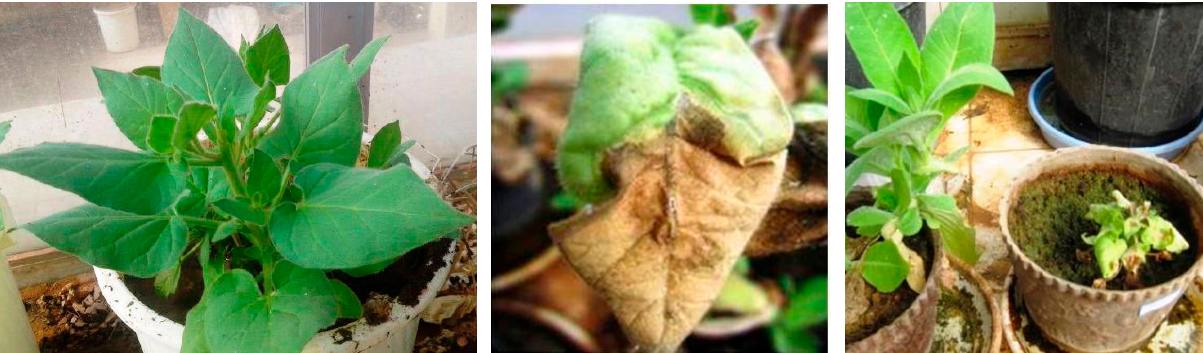
Figure 4. Healthy plant of tobacco (control, left), progressive development of tobacco leaf symptoms after inoculation with Xylella fastidiosa . Necrosis of leaves 40 days after inoculation (middle). Stunting of tobacco plant four months after inoculation